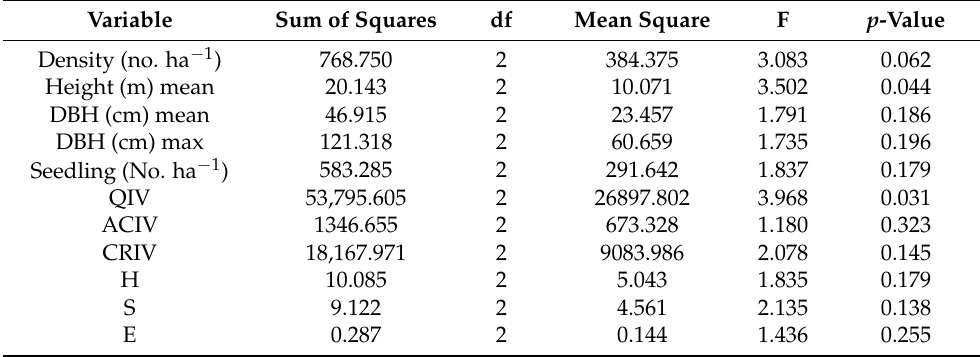
Table 6. Analysis of Variance results for stand structure and composition of trees (DBH ≥ 5 cm and height ≥ 1.5 m) in a naturally-regenerated broadleaf forest in the Arasbaran biosphere reserve in Iran ( n = 30). Equations for variables are listed in Table 1. QIV: Q. macranthera Important value.